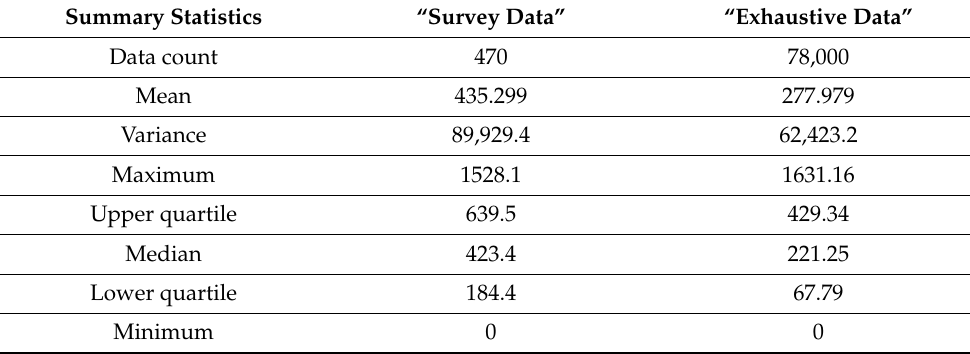
Table 1. Summary statistics Walker Lake